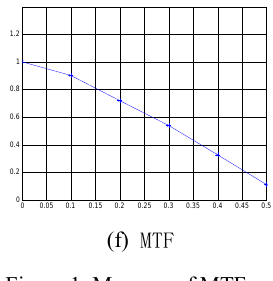
Figure 1 . Measure of MTF Supposing the GeoEye-1 to be invariant system of linear displacement, the filter kernels of different band based on MTF are three-dimensionality shown from figure 2 (a) to figure 2 (d).